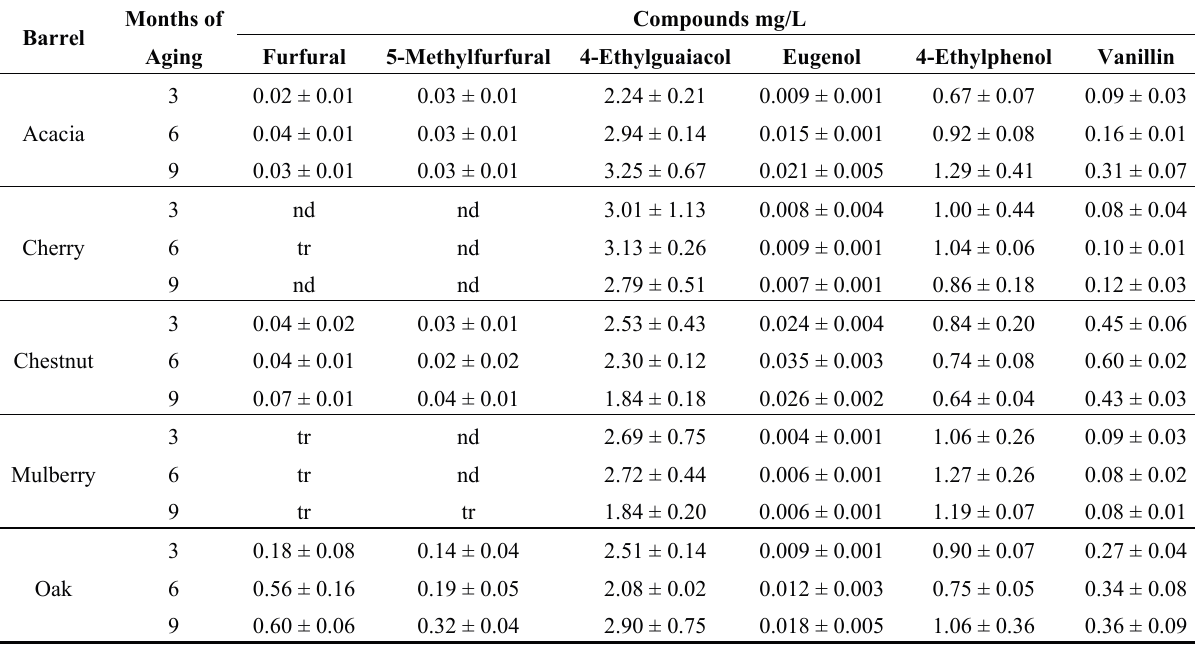
Table 4. Principal compounds studied in Raboso Piave wines aged nine months in 225 L barrels of acacia, cherry, chestnut, mulberry, and oak (nd: not detected; tr: trace (<0.01 ppm)